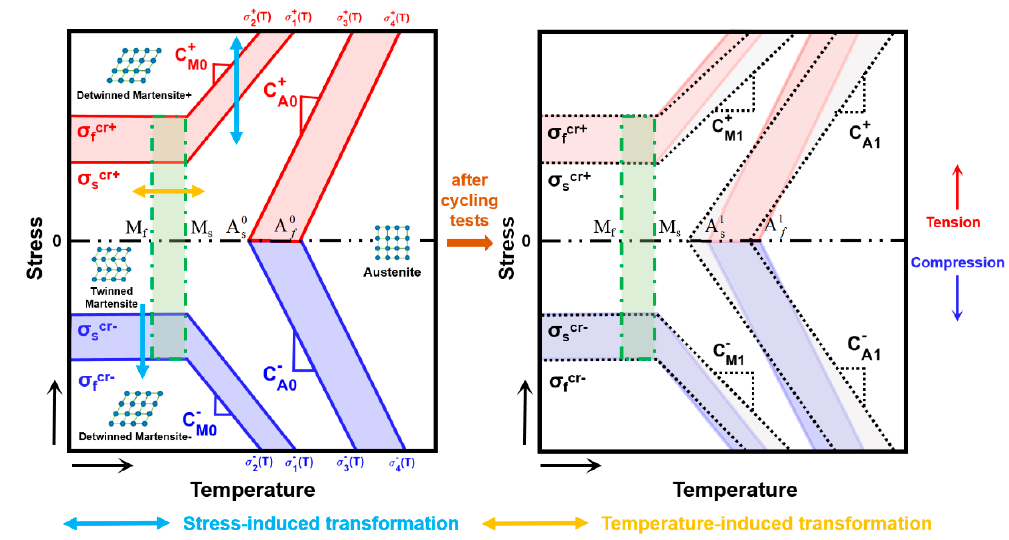
Figure 1. Asymmetric tensile-compressive phase diagram predicting the critical stresses for shape memory alloys (SMAs) before cycling tests ( left ) and after cycling tests ( right ). The solid lines represent the critical stresses for SMAs in the initial unstable state and the dotted lines represent the critical stresses for SMAs in the final stable state.